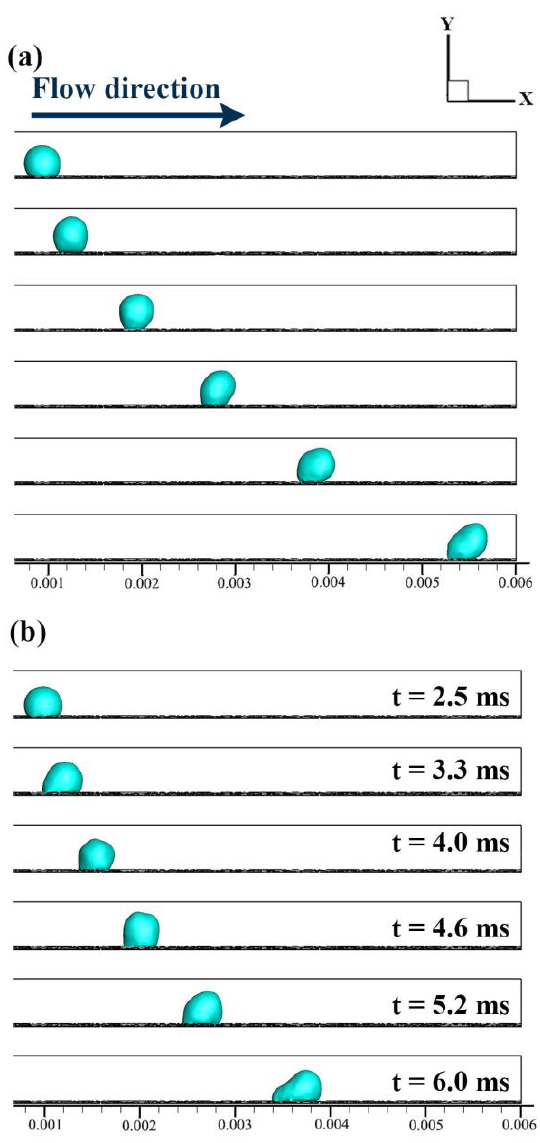
Figure 10. Spatio-temporal droplet evolution on the GDL surface with a fiber diameter of 15 µm at contact angles of ( a ) 120˚ and ( b ) 105˚, respectively.